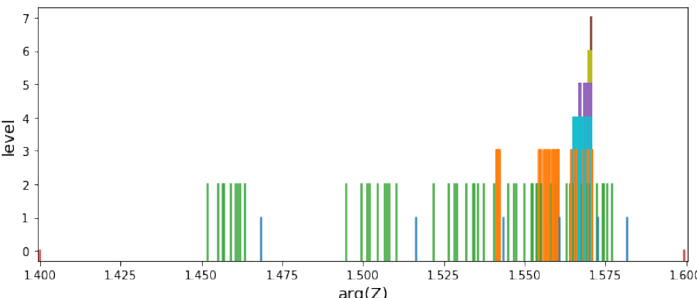
Figure 18 . States between γ lvlcut = 8 . The maximum level reached is 7 so there are no further states for this choice of